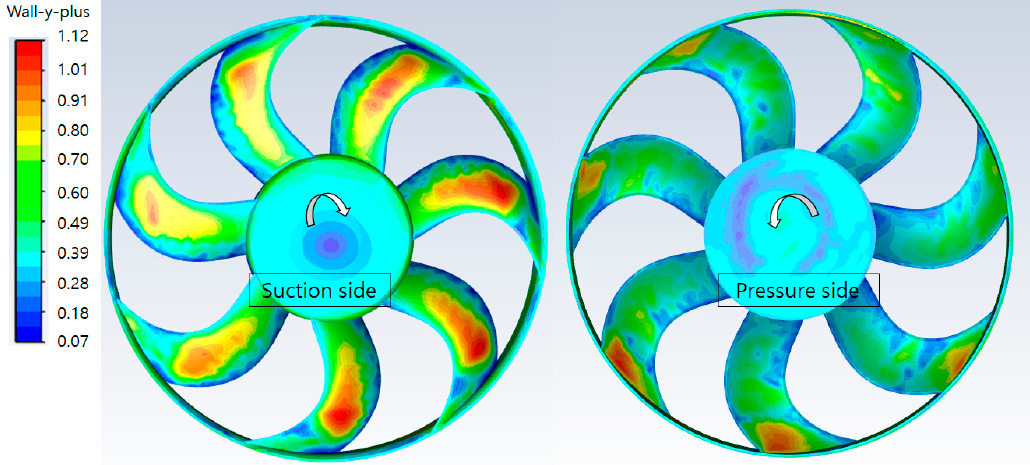
Figure 4. y+ value distribution on suction and pressure sides of the axial fan. Figure 4. y + value distribution on suction and pressure sides of the axial